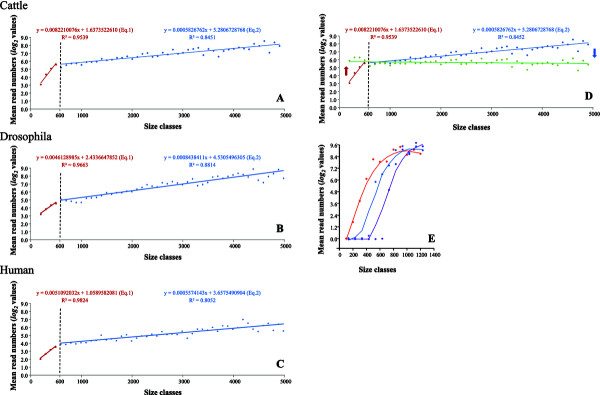
Method implemented to correct the biases linked to transcript size. Size classes were built every 100 bp for transcripts < 5000 bp, as too few transcript numbers were observed with a size ≥ 5000 bp leading to scattered dots. The dotted line separates the red regression line corresponding to transcripts < 600 bp and the blue one to transcripts ≥ 600 bp. The vertical axis corresponds to log2 transformed values of read numbers. A) Cattle sample 1479. B) Drosophila sample SRR384925 (7132 genes with a single transcript). C) Human sample SRR1177729 (16,228 genes with a single transcript). D) Representation of sample 1479 after correction (green). E) RNA-Seq simulated data using rlsim, where Loess smoothing was applied to each series. The blue points correspond to a run where the sequenced fragments are in the range of 250–450 bp, the red one to the range of 450–650 bp, and the violet one to the range of 650–850 bp.